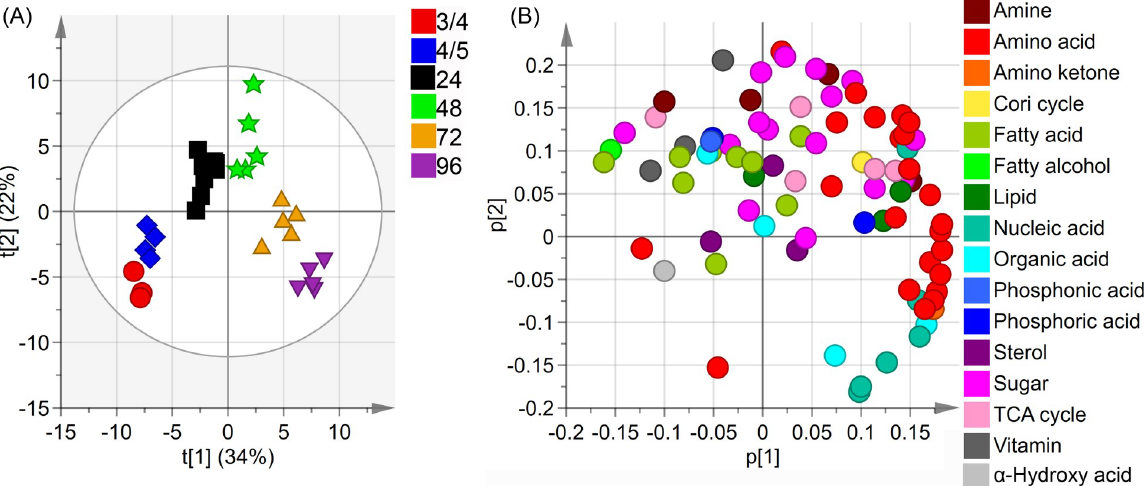
Fig 2. Score plot (t1/t2) for overview model after removal of sample 18_1. 2(A) : The score plot showed the developmental stages. The first and second component explained 34% and 22% of the variation respectively. Different colours and shapes were used for the developmental samples: 3/4 hpf–red square, 4/5 hpf–blue rhombus, 24 hpf–black square, 48 hpf–green star, 72 hpf–orange pyramid and 96 hpf–purple triangle. 2(B) : The loading plot showed the distribution of the identified metabolites. The metabolites were coloured according to metabolite class.